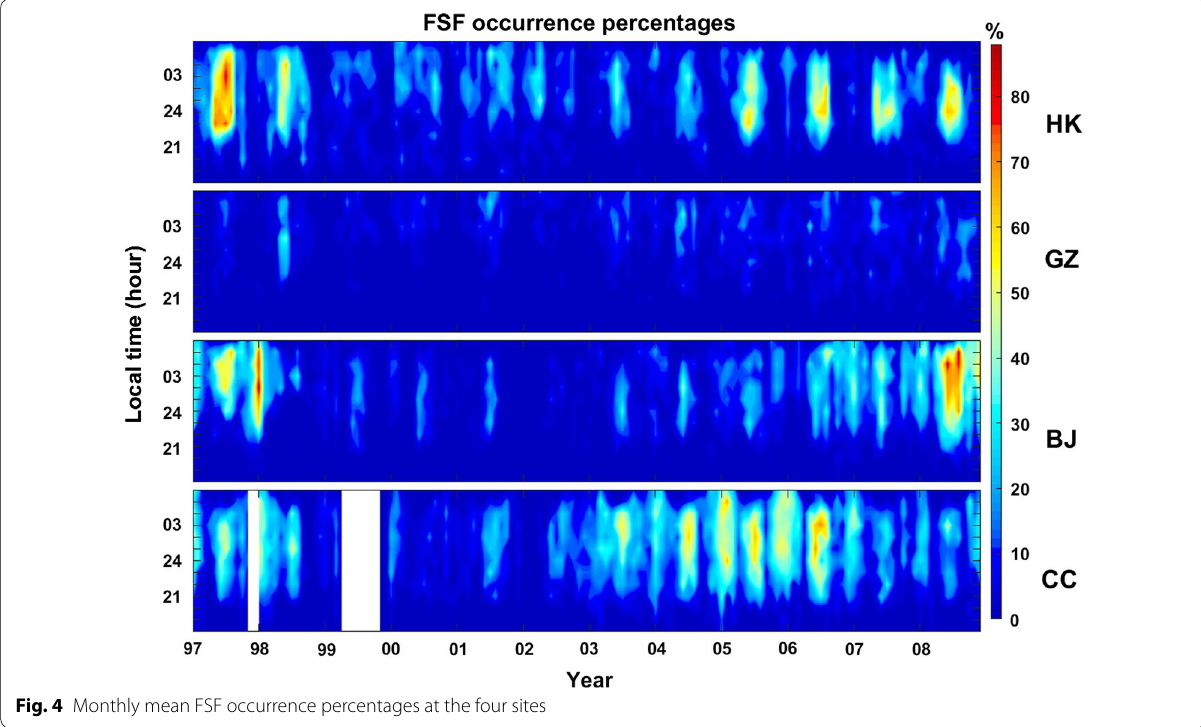
Fig. 4 Monthly mean FSF occurrence percentages at the four sites